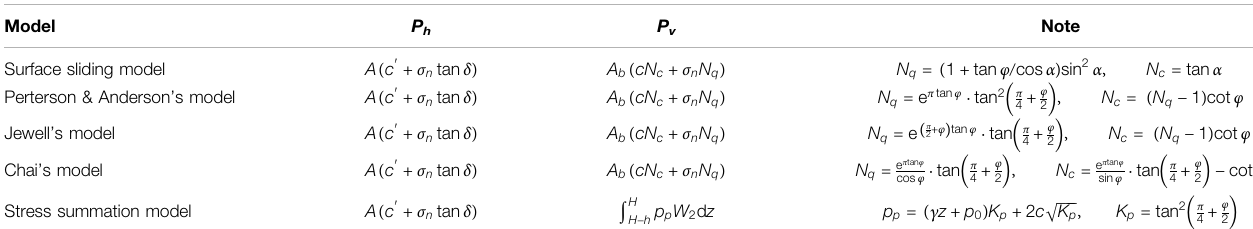
TABLE 3 | Comparison of fi ve models for the denti-geogrid resistance.